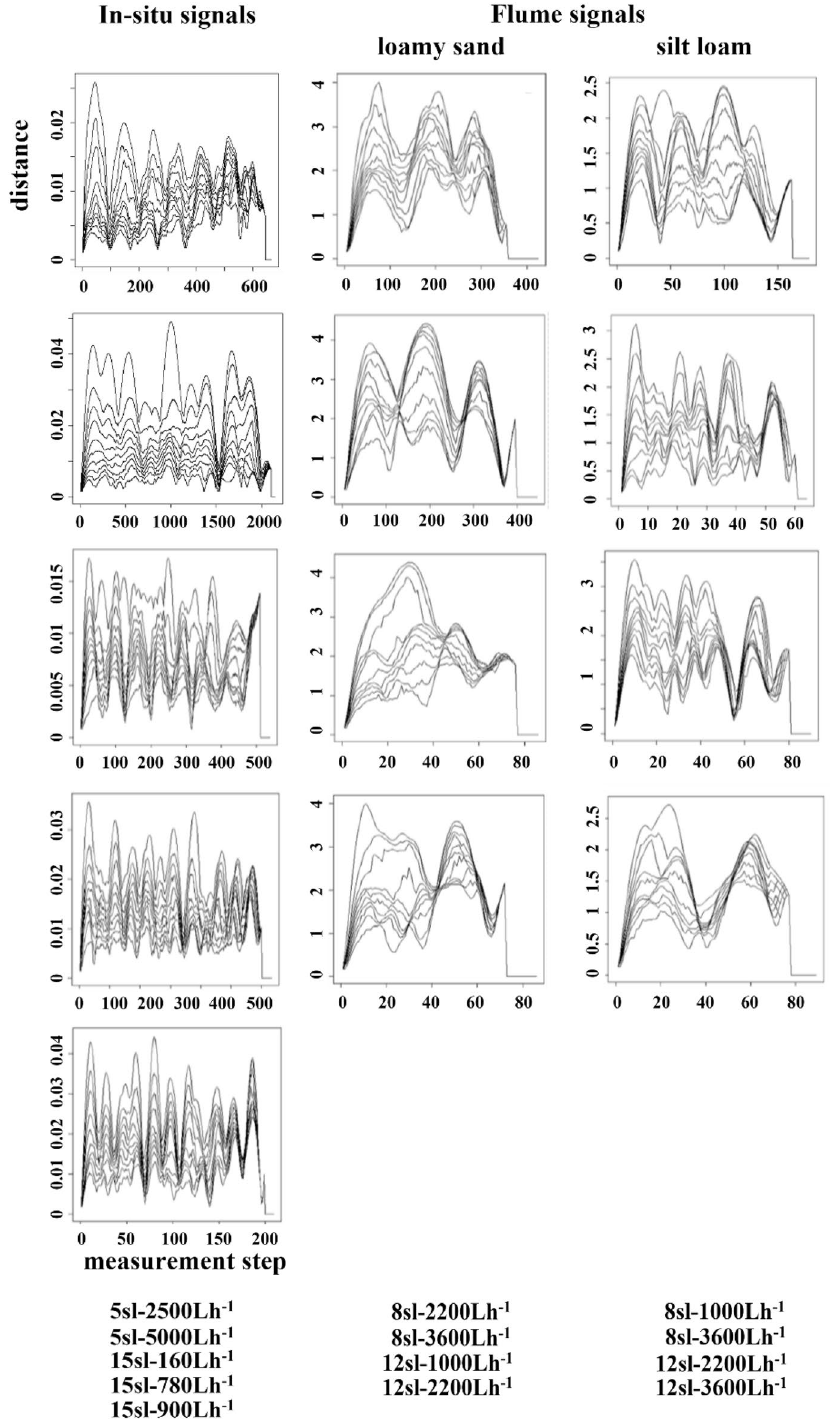
Figure 5. Screening for stationary nonlinear rill-bed dynamics with space–time separation plots. The plots indicate non-stationarity of three flume shadow attractors: 12 sl–1000 Lh −1 (loamy sand), 12 sl–2200 Lh −1 (loamy sand), and 12 sl–3600 Lh −1 (silt loam) since contour cycles require many measurement steps to complete in contrast to contour cycles in the other plots oscillating with much higher frequency. Since these flume rill profiles may be non-stationarity due to relatively short lengths (ranging from 1.18 to 1.80 m in Table 1), we sought to remedy this by increasing profile length with out-of-sample machine-learning